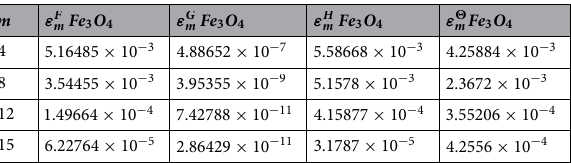
Table 2. Total squares residual errors for Fe 3 O 4 . When φ Fe 3 O 4 = φ Cu = 0.02, Pr = 6.2, Re ω = 0.3, Re � = 0.13.